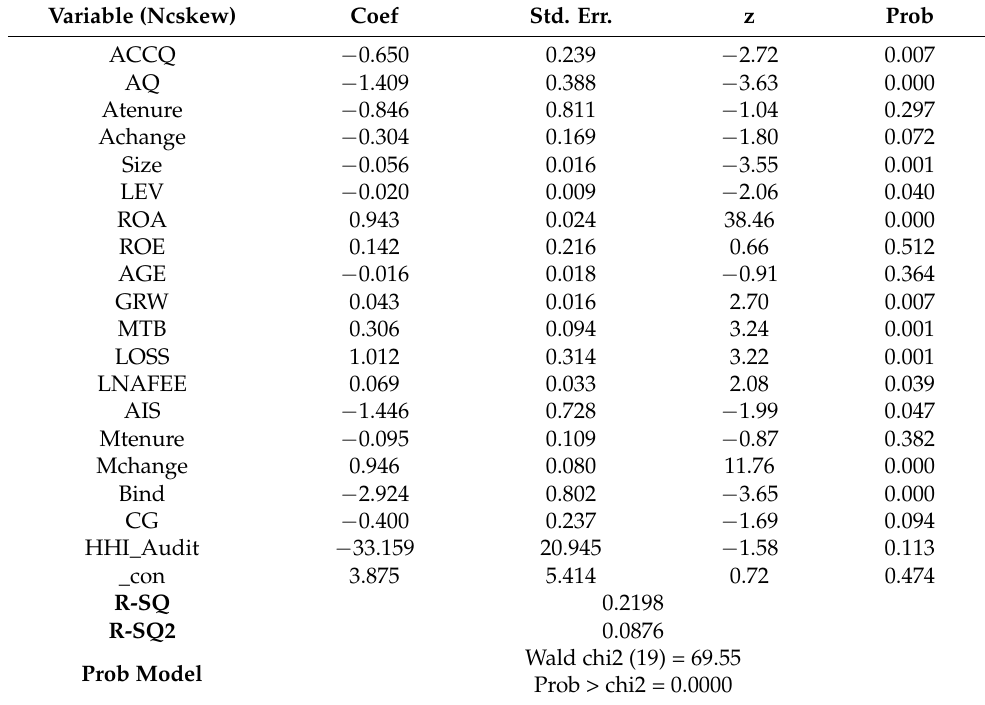
Table 8. The results of the first